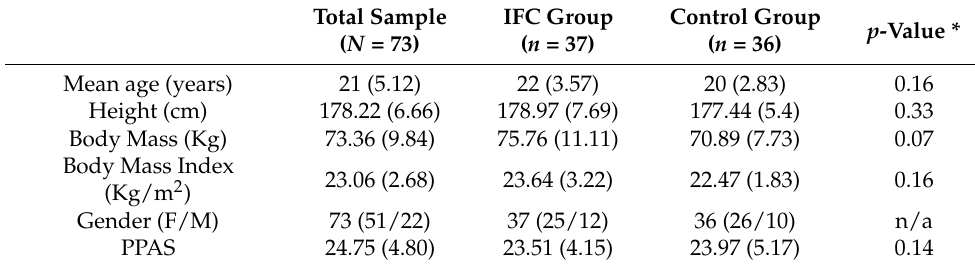
Table 1. Baseline clinical and demographic features of the